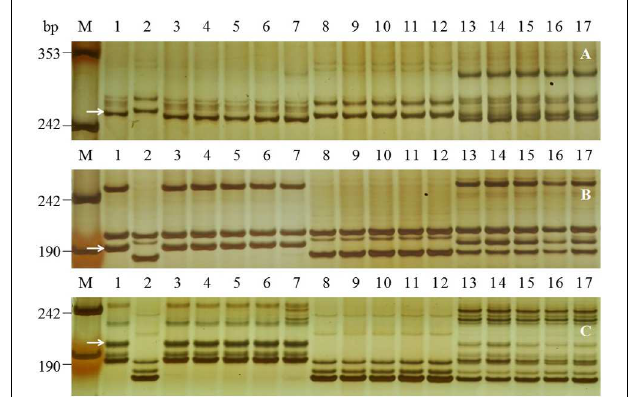
FIGURE 2 | Examples of amplification patterns of PmFG -linked polymorphic SSR marker Cfd81 (A) and SNP-derived markers Bwm20 (B) and Bwm25 (C) in the parents and selected F 2 : 3 families of FG-1 × Mingxian 169 in 8% silver-stained non-denaturing polyacrylamide gels. Lanes M, pUC18 Msp I; lanes 1-2: FG-1 and Mingxian 169; lanes 3–7: homozygous resistant F 2 : 3 families; lanes 8–12, homozygous susceptible F 2 : 3 families; lanes 13–17 heterozygous F 2 : 3 families. White arrows indicate the polymorphic band of